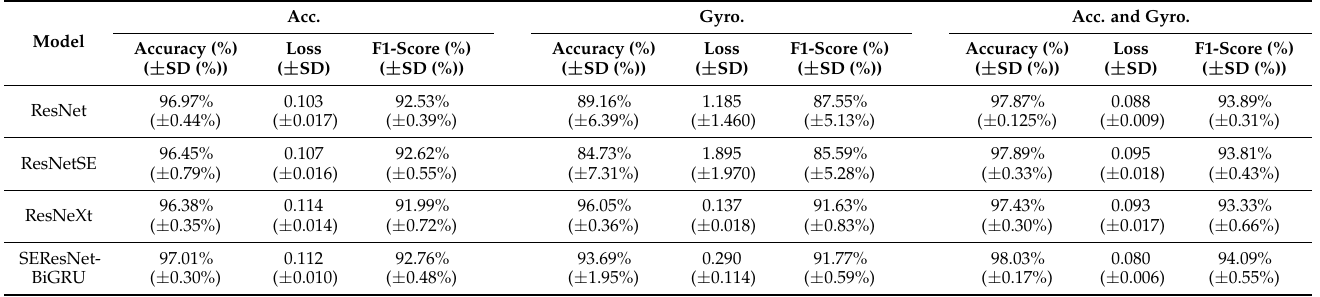
Table 4. Recognition effectiveness of DL models on the HAPT dataset by using different sensor